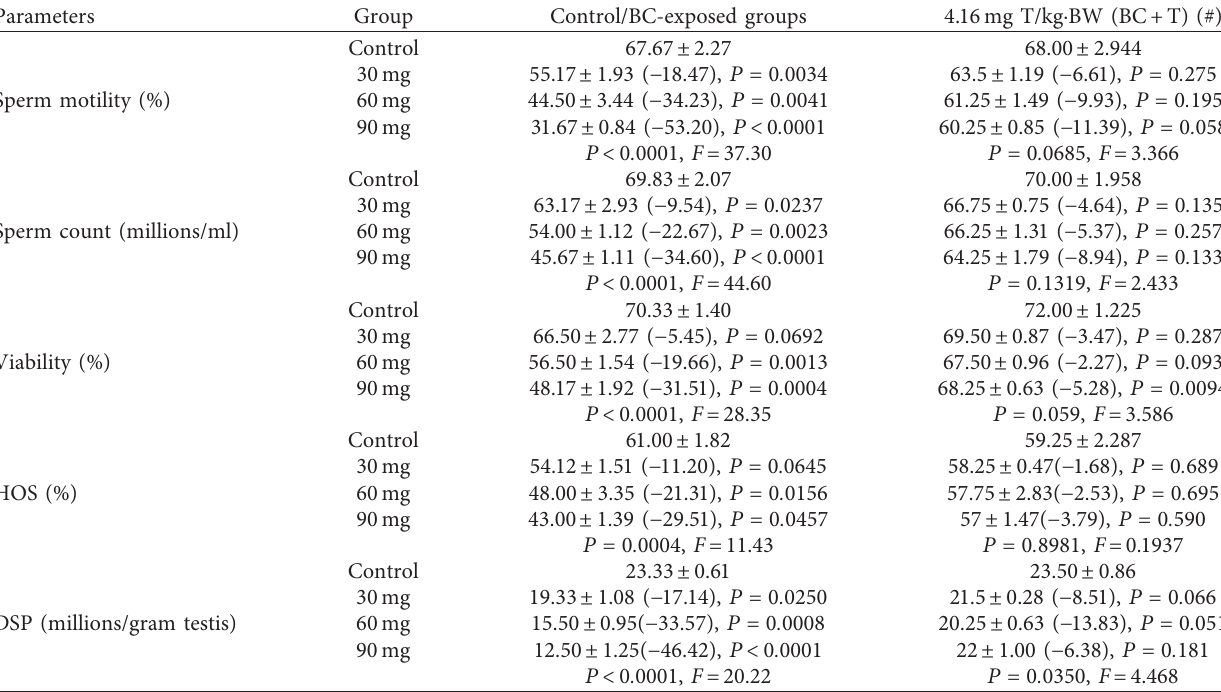
Values are mean ± SEM of six individuals; # denotes n � 4. Values in the parentheses are percent changes from that of control. Significance was checked from controls to F1 BC exposed and BC exposed administered with T groups. Significance was considered at P < 0 . 05, where BW � body weight; HOS � hypoosmotic solution; and DSP: daily sperm